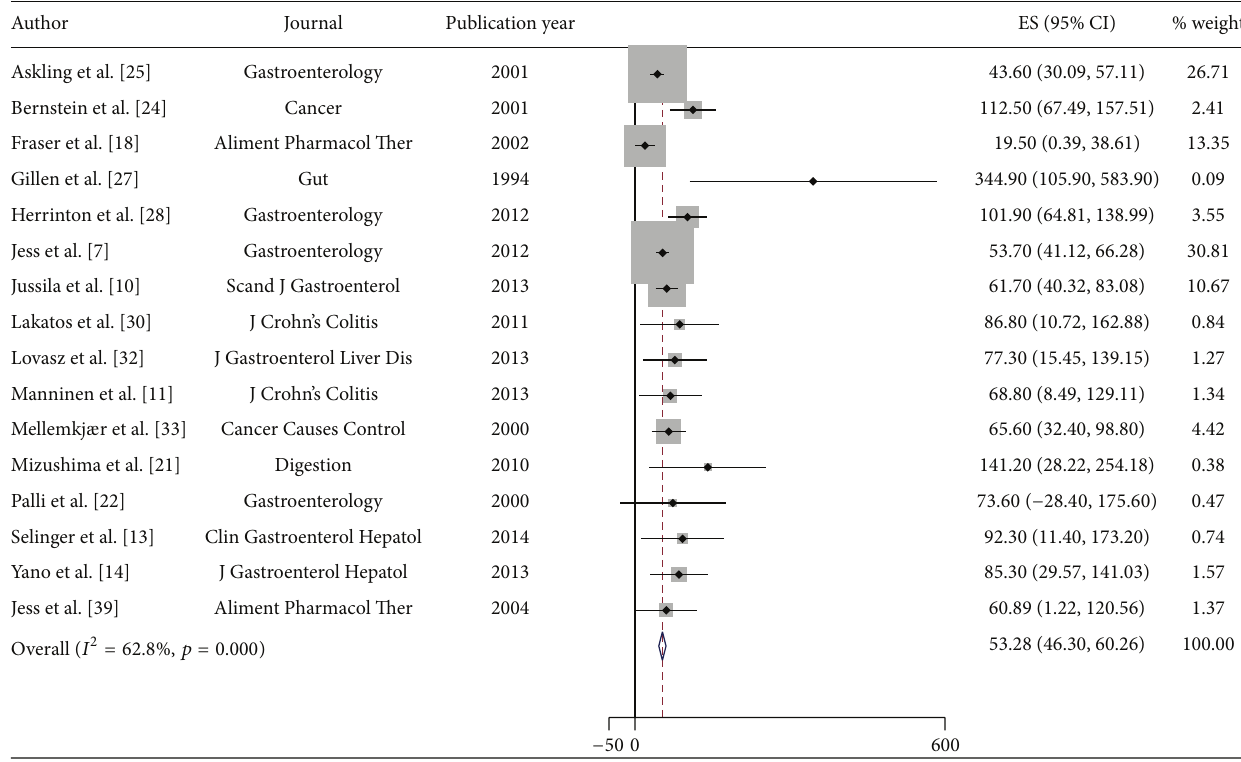
the incidence rates ranged from 0.0/100,000 py (95% CI 0.0– (Table 3). A pooled incidence rate of 0.6/100,000 py (95% CI − 0.5–1.6/100,000) for CD was obtained. Substantial hetero- geneity prevented pooling of estimates for UC